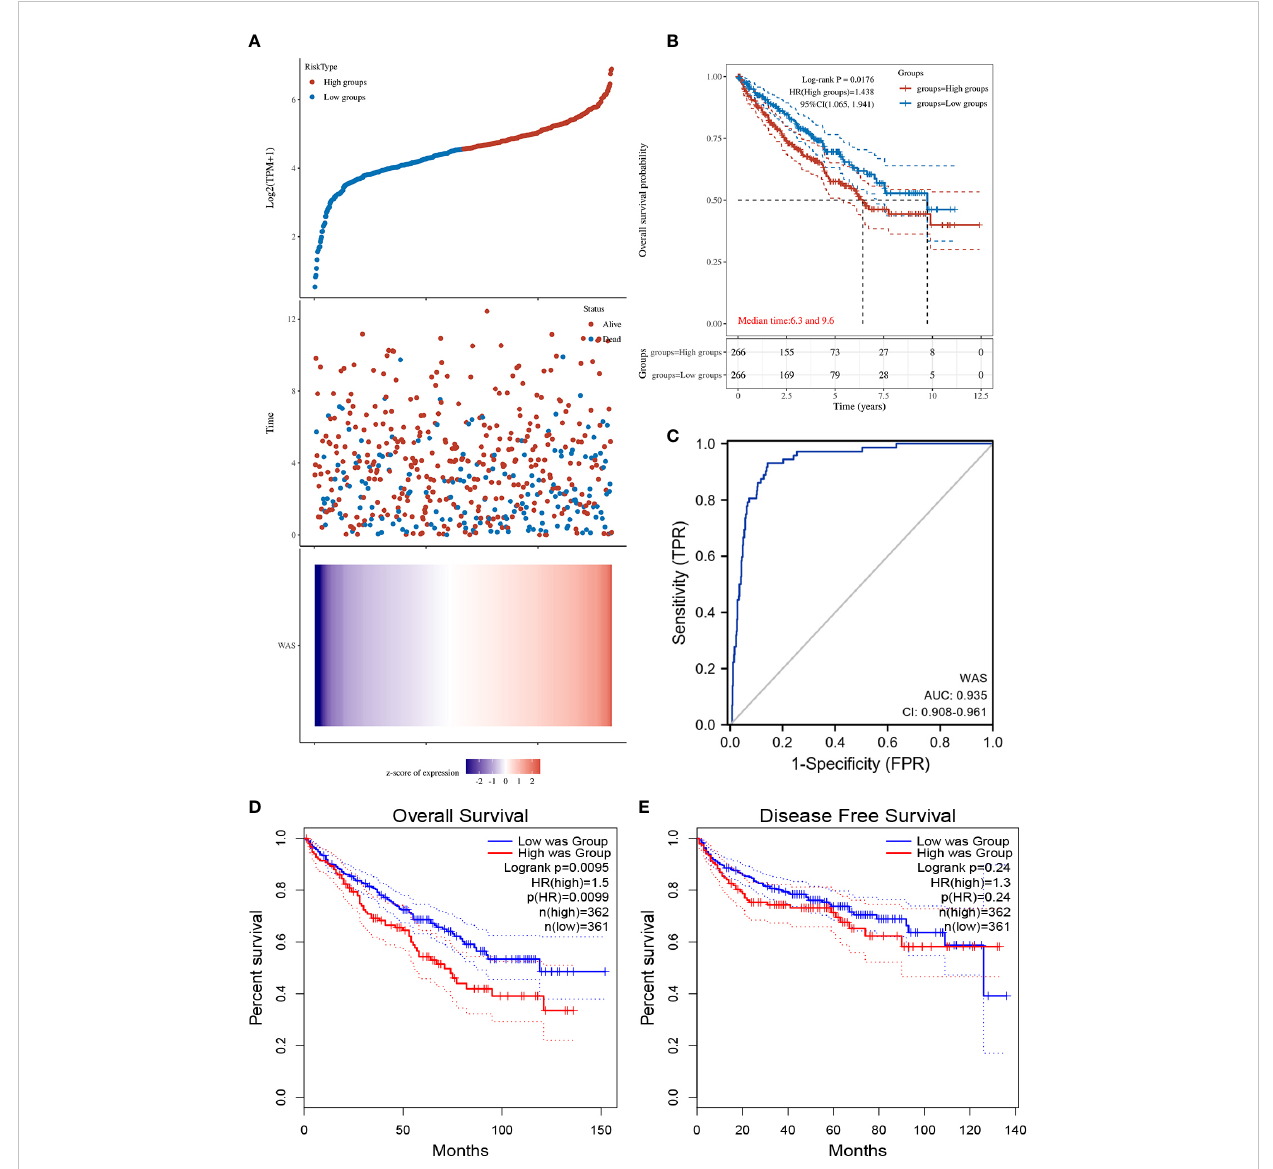
FIGURE 3 (A) WAS expression distribution and survival status. 0: dead, 1: alive. The blue dots represent the surviving ccRCC patients, and the red dots represent the dead ccRCC patients. (B) Kaplan-Meier survival curves indicated that ccRCC patients with high WAS mRNA expression had a shorter OS. (C) Diagnostic ROC curve of WAS. (D) The relationship between WAS expression and OS was obtained by GEPIA. (E) The relationship between WAS expression and DFS of ccRCC was obtained by GEPIA. OS, overall survival; DFS, disease free